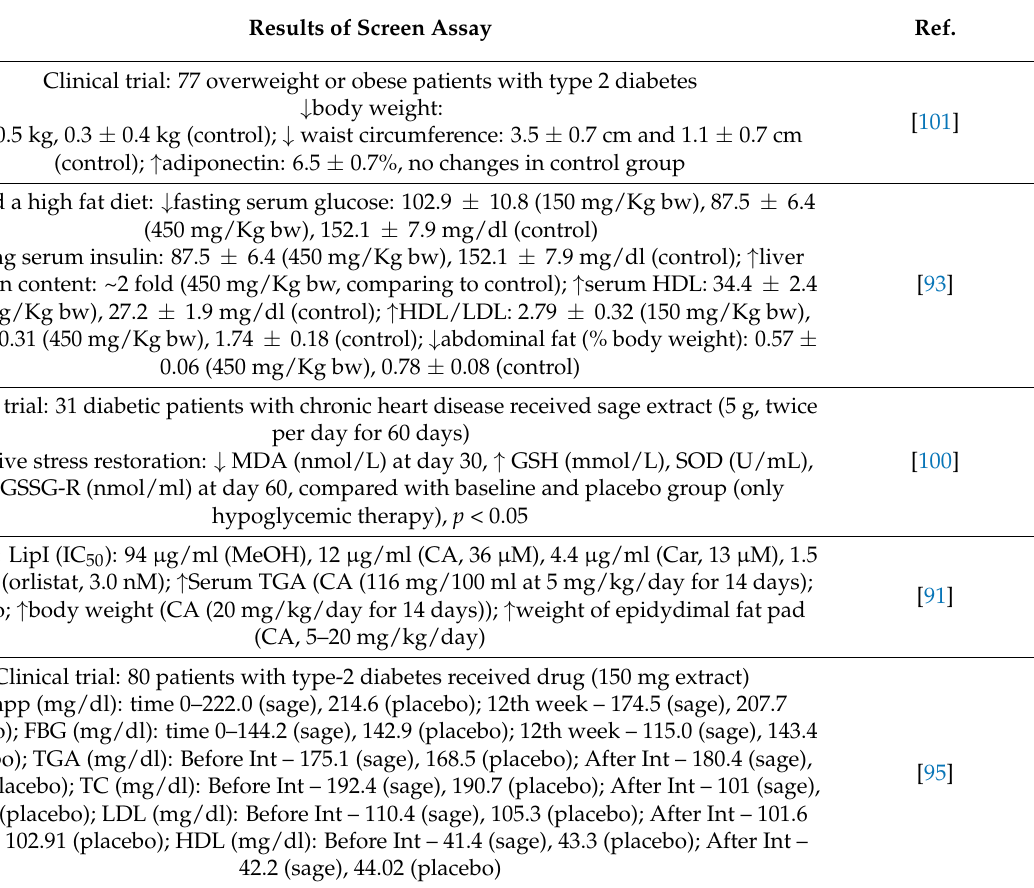
Table 4. Antidiabetic and anti-obesity properties of phenolic-enriched extracts of distinct Salvia species—In vivo and clinical experiments. Salvia